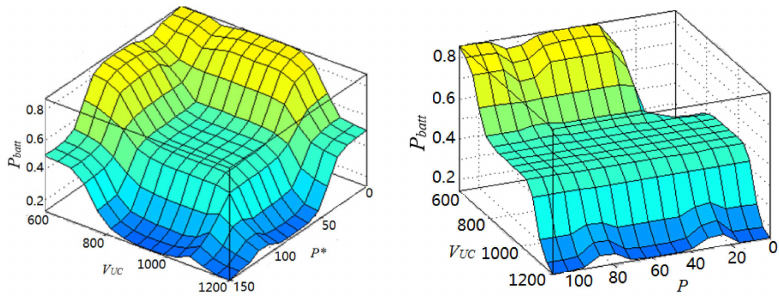
Figure 22. The relationship between the input and output of mode III.